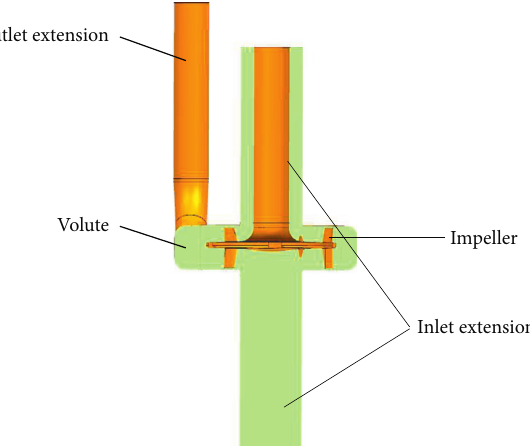
Figure 3: Sump pump fluid domain.